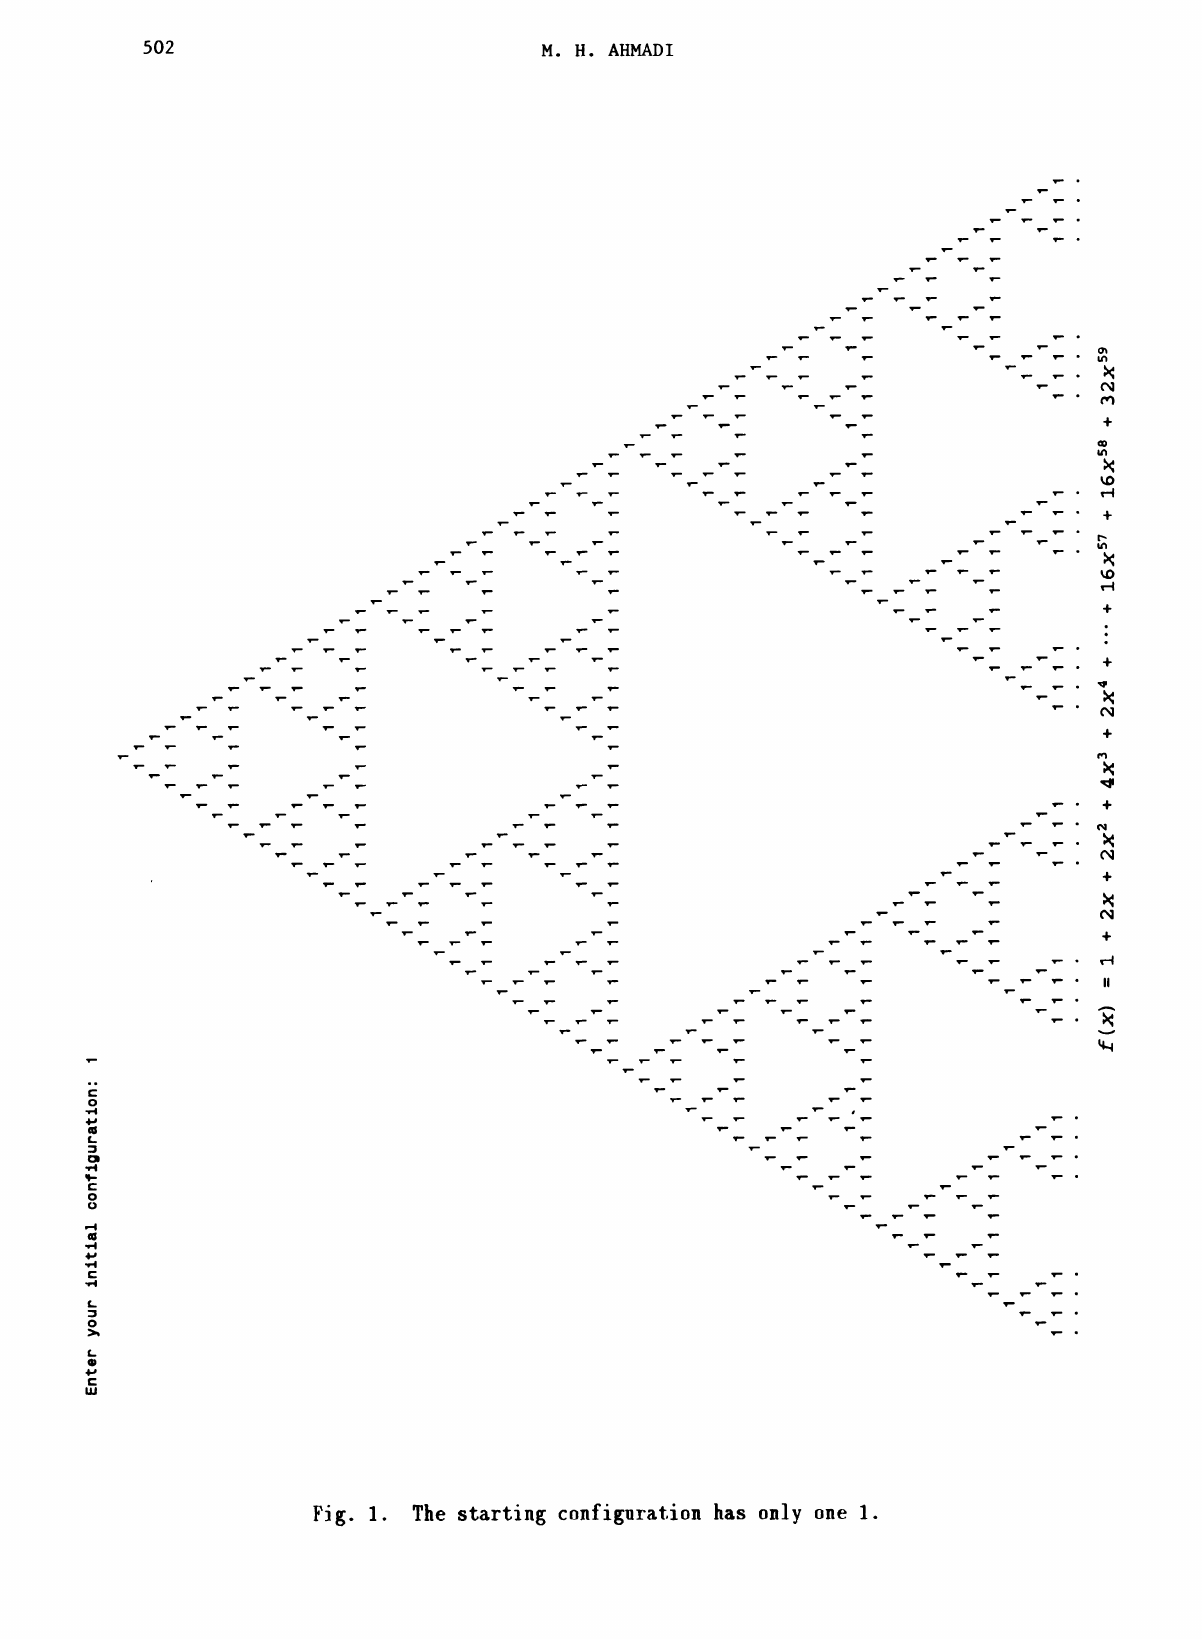
Fig. l. The starting configuration has only one